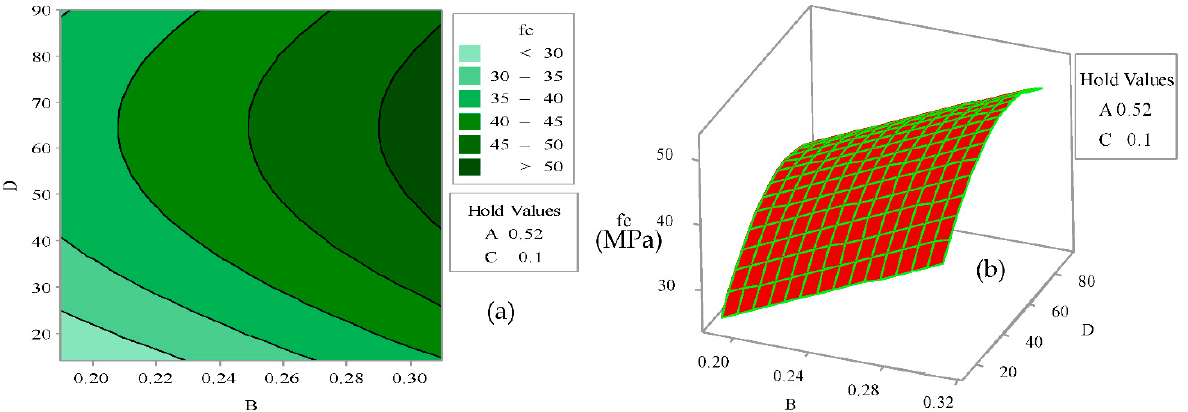
Figure 12. Effects of D and B on fc (MPa) ( a ) 2-D contour lines ( b ) 3-D surface. A is water/binder ratio, B is binder/aggregate ratio, C is CNA/(CNA + PLC), and D is curing age (d).